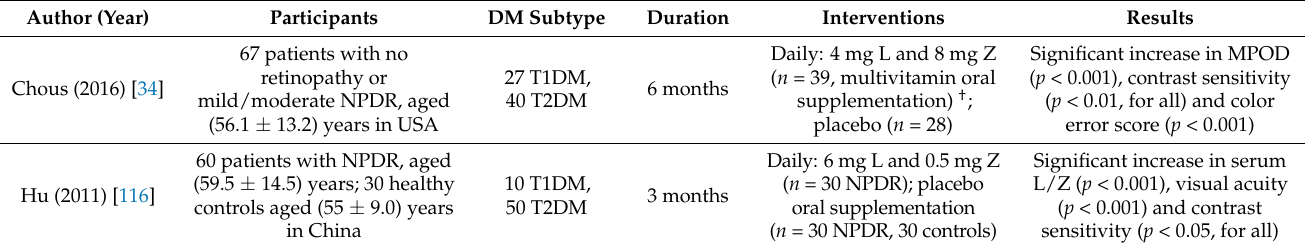
Table 4. Characteristics of the eligible randomized clinical